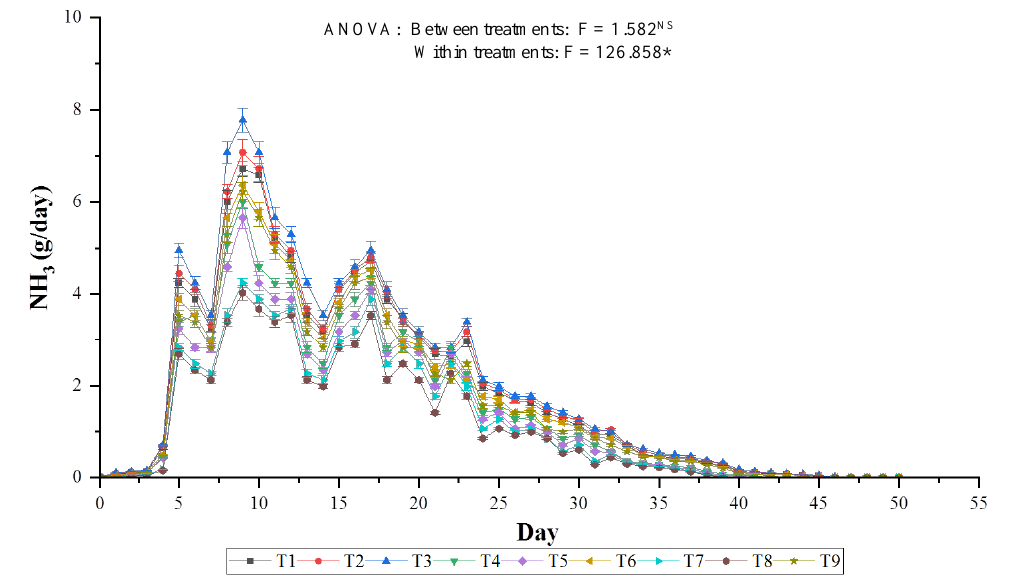
Figure 8. Profile of NH 3 emission (g/day) variations among different composting treatment groups. ‘*’ indicates a significant difference, and ‘NS’ indicates a non-significant difference at p < 0.05 by ANOVA.